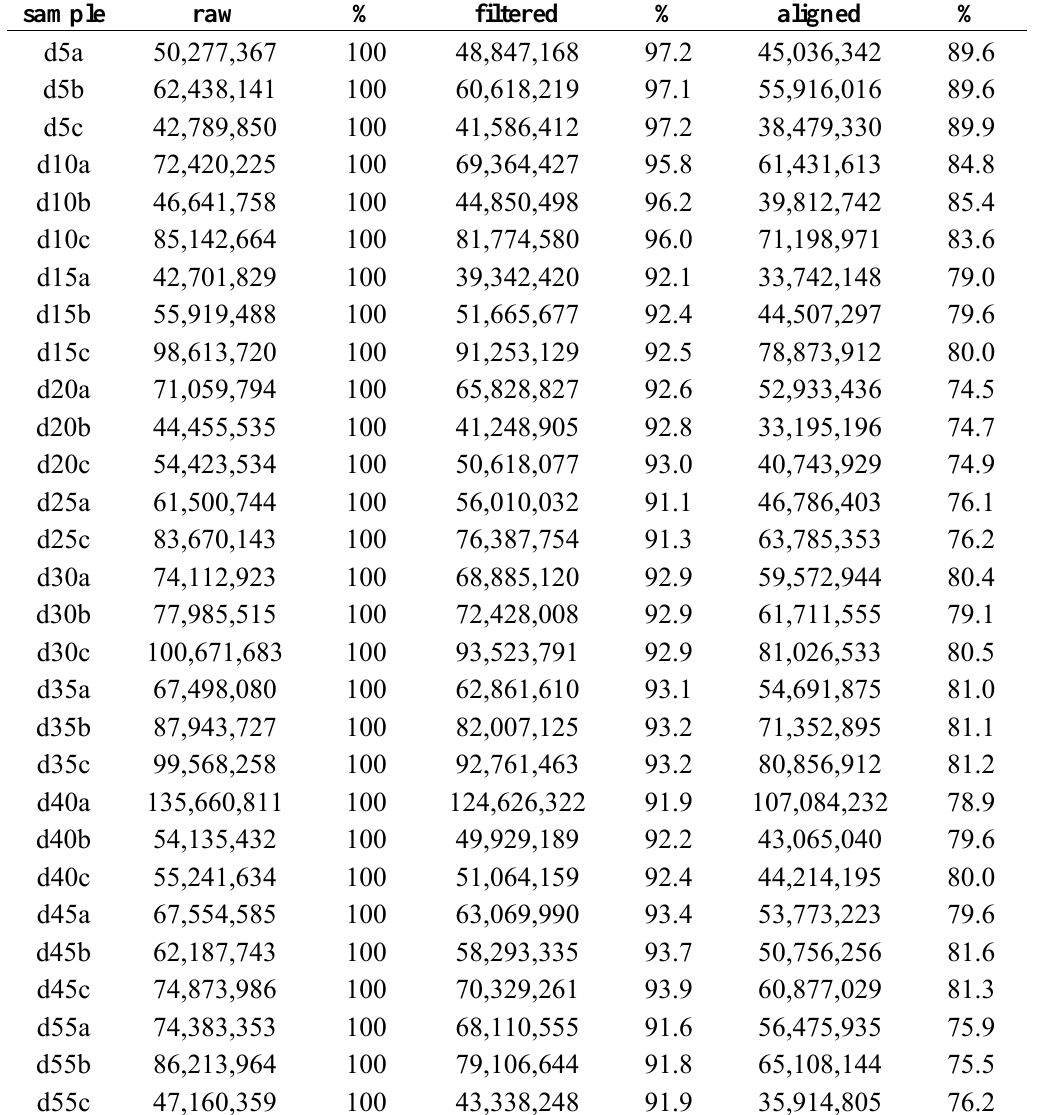
Table 3. Statistical results from RNA sequencing analysis (number and percentage of raw, filtered, and aligned reads). Three replicates (a, b, and c) are shown for each time point (days